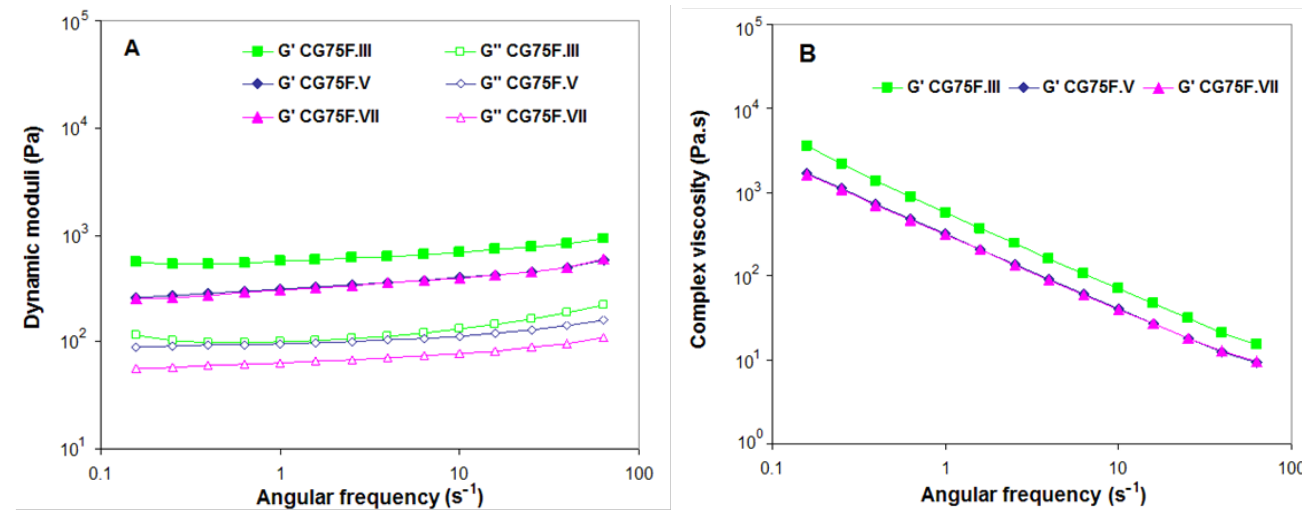
Figure 10. Effect of the cryogenic cycles number (III, V and VII) on the variation of ( A ) storage modulus (G′) ( solid symbols ) and loss modulus (G″) ( open symbols ), ( B ) complex dynamic viscosity (|η*|) function of angular oscillation frequency at 25 °C for XG - based composite hydrogels obtained with a weight ratio between XG and PVA of 3:1, and Feteasca Neagra polyphenolic extracts.